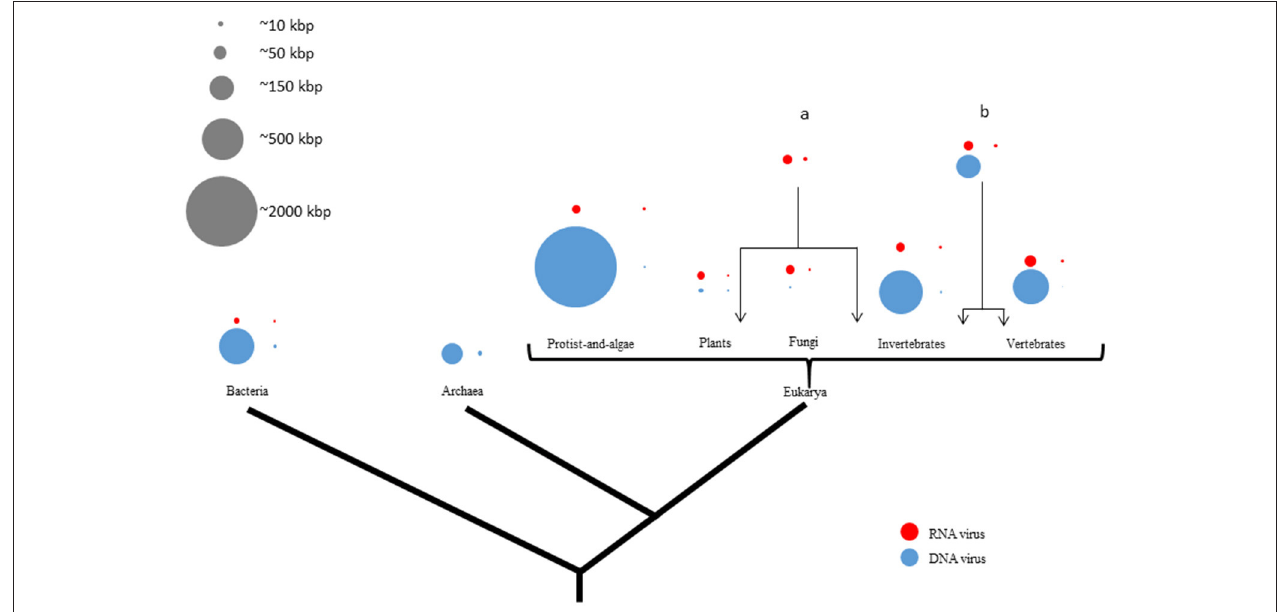
FIGURE 1 | Viral genome sizes are non-randomly distributed in the tree of life representing their hosts. There are four circles by domain or phyla from phylogenetic tree of life which proportionally represent the largest and the smallest genome size from either RNA- (red) or DNA (blue) viruses. Gray circles represent a genome-size scale approximation. Larger and smaller viruses appear to infect mainly eukaryotes. There is more genome-size diversity in DNA viruses than in RNA viruses in all three domains of life. While DNA viral genome exhibits a size range of four orders of magnitude, RNA viral genome sizes are much more restricted. On the contrary, RNA viruses are more widely distributed among eukaryotes than among prokaryotes. Moreover, RNA viruses infect more phylogenetically-distant hosts like both plants and invertebrates (a) or both invertebrates and vertebrates